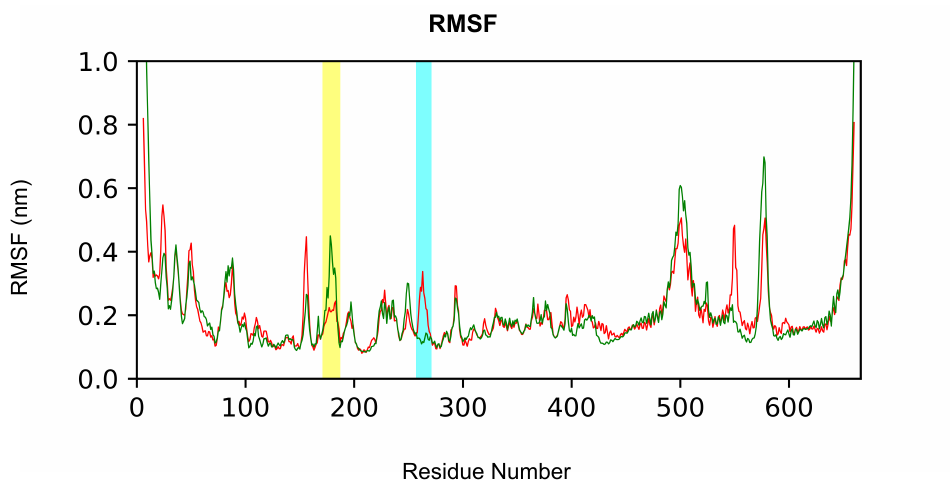
Figure 8. Root mean square fluctuations (RMSF) of NAPA-unbound form (red) and NAPA-bound (green) forms of IKK α . The portions with fewer fluctuations in the bound state are highlighted in cyan and yellow. RMSFs were computed for all atoms in the 300 ns MD